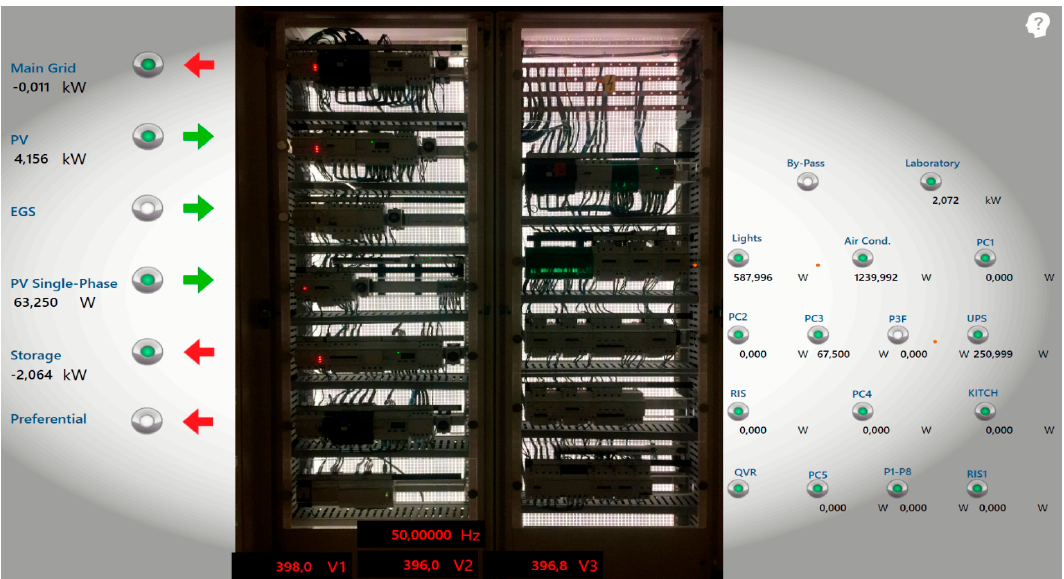
Figure 10. Electrical switchboard of the LAMBDA MG LAB.